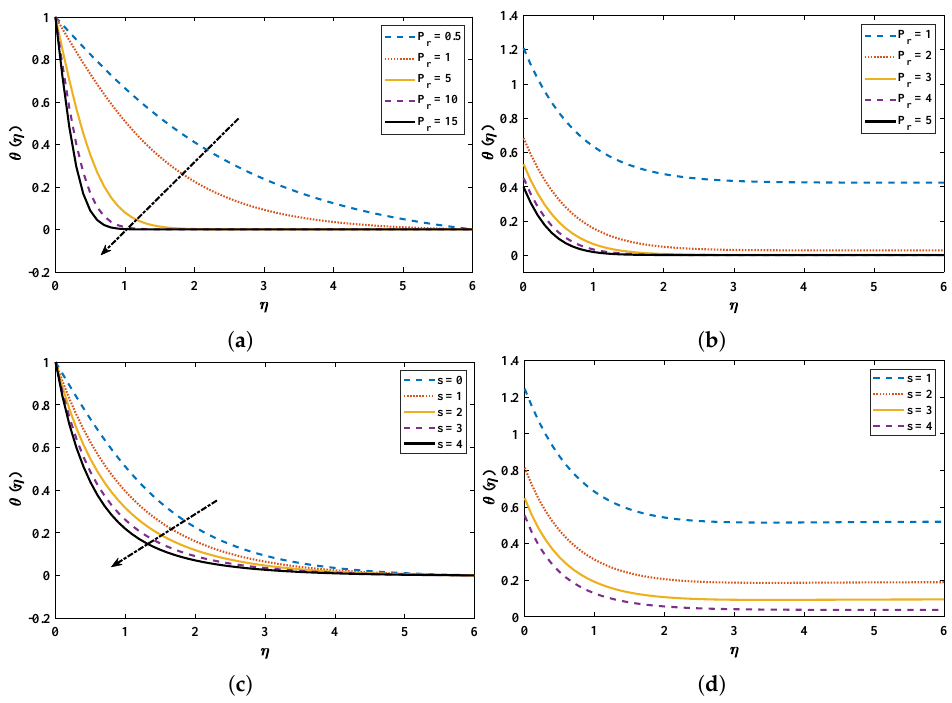
Figure 10. Graphical study of the influences of alterations in the temperature profile of the fluid brought about by variations in both the Prandtl number and the heat index: ( a , b ) with isothermal boundary conditions and ( c , d ) with isoflux boundary conditions.